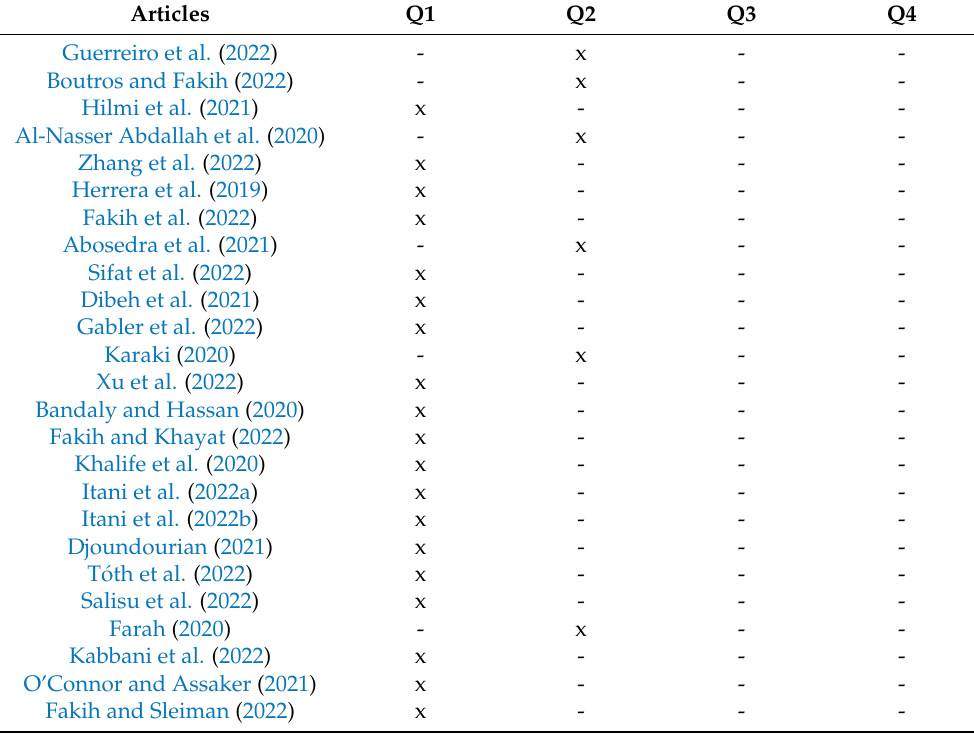
Table A1. Published papers in the School of Business per quartile, 2018–2022.